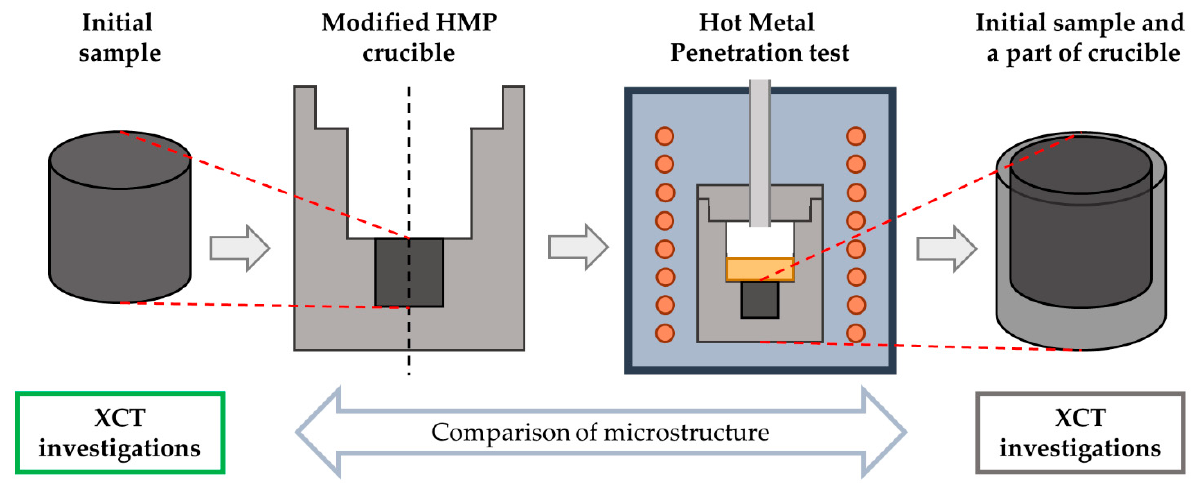
Figure 3. Scheme of the designed new investigation method—the XCT–HMP test.